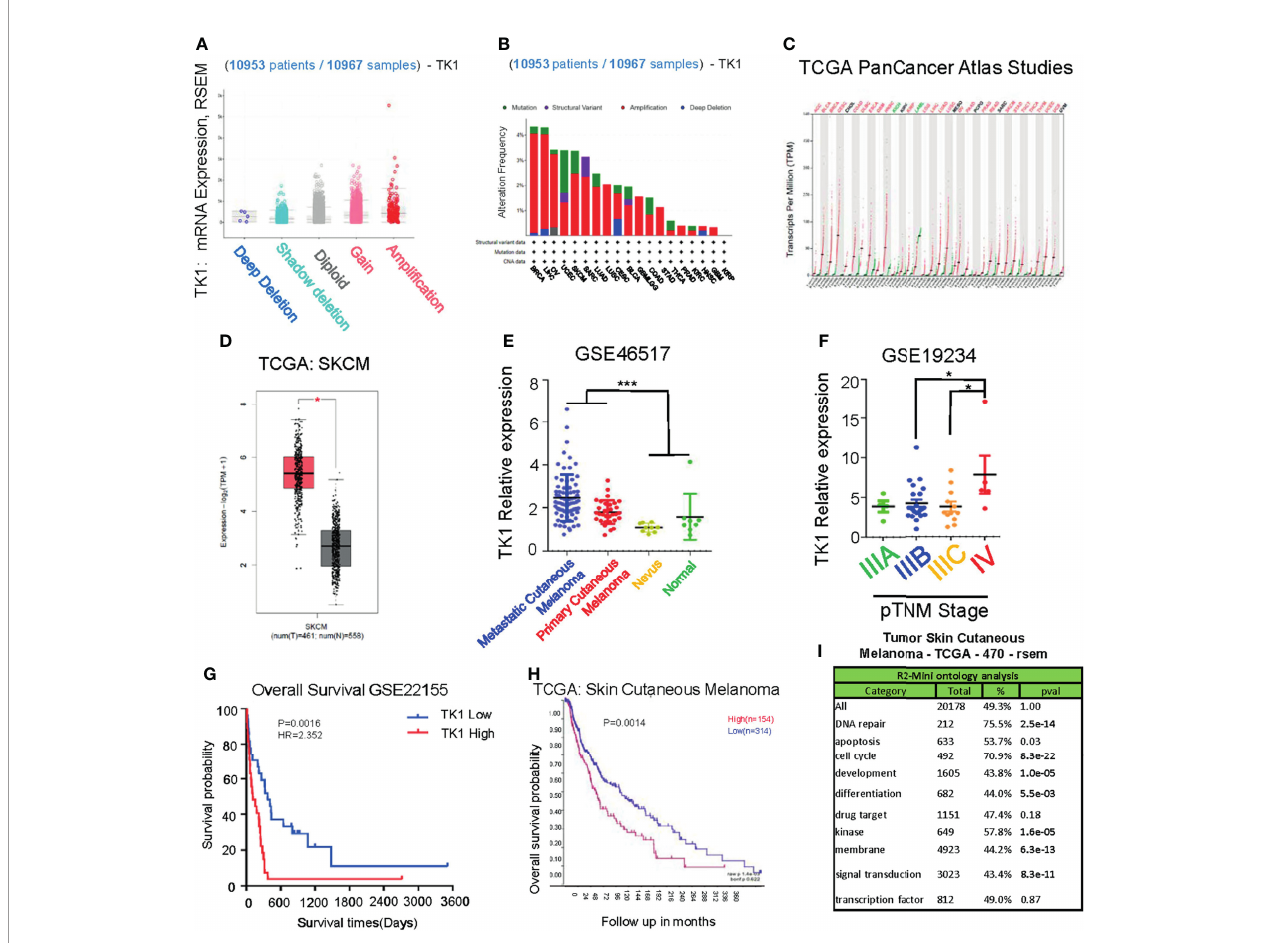
FIGURE 1 | Upregulation of thymidine kinase 1 (TK1) in skin cutaneous melanoma (SKCM) in databases. (A) Pan-Cancer analysis of TK1 in The Cancer Genome Atlas (TCGA) database. (B) Structural variants of TK1in diversi fi ed tumorsin10,953 patients/10,967 samples. (C) The elevated TK1 level in 25 kinds of malignancies. (D, E) Relative TK1expression innormal and tumor tissues. The tumortissues were 461, andthe normal tissues were 558. (F) Relative TK1expression indifferent pTNM stages fromIIIA to IV. (G,H) Unfavorable prognosisdue to higher TK1 levelsin Gene Expression Omnibus(GEO)and TCGA cohorts. (I) Gene Ontology (GO) analysis to reveal TK1function in cancer.*p< 0.05, ***p <